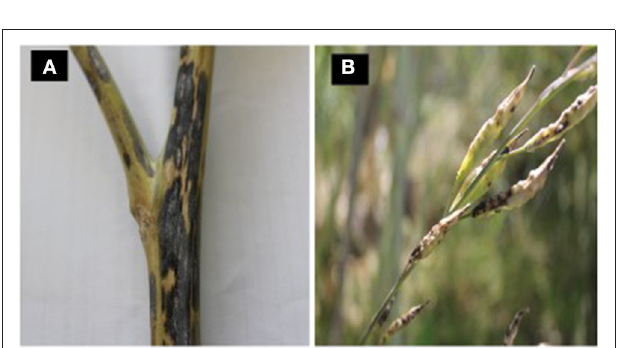
FIGURE 4 | Stem and pod lesions caused by Neopseudocercosporella capsellae on Brassica nigra (A) and B. juncea (B) .